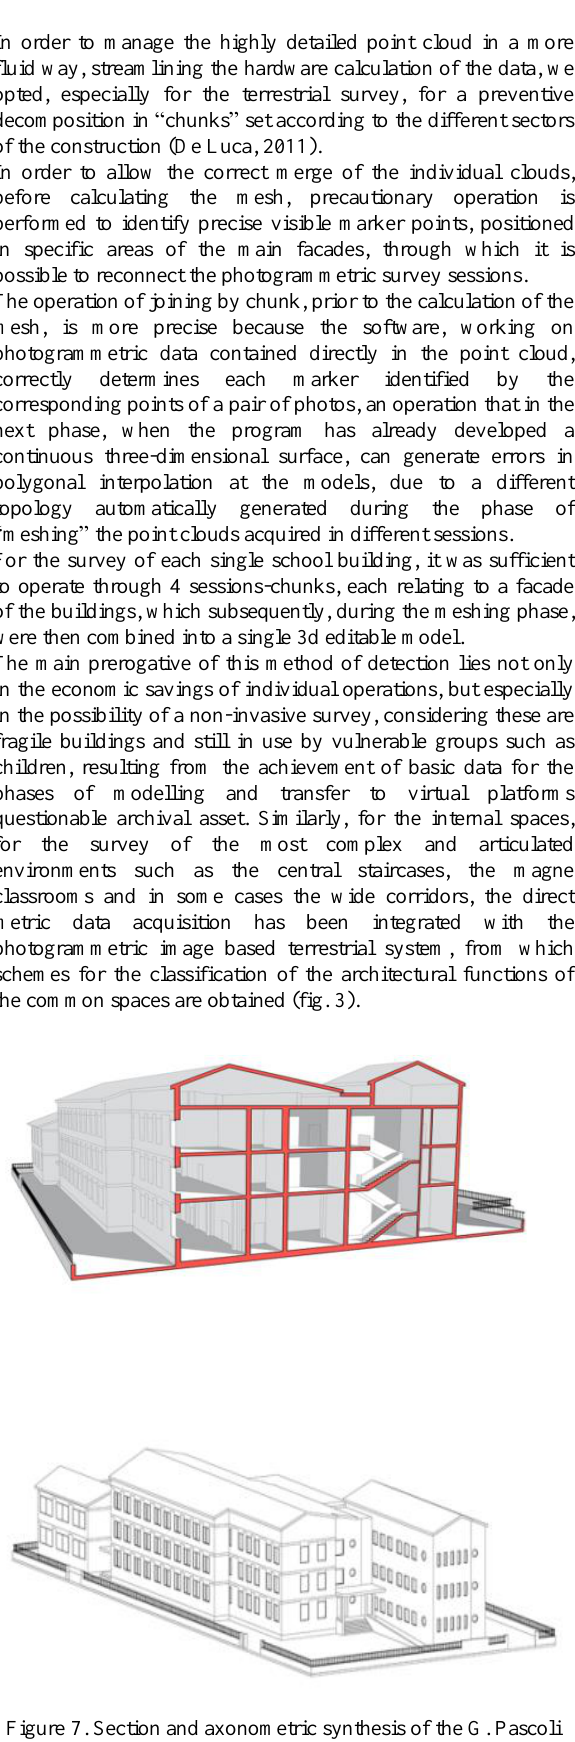
Figure 10. Axonometric exploded view of the